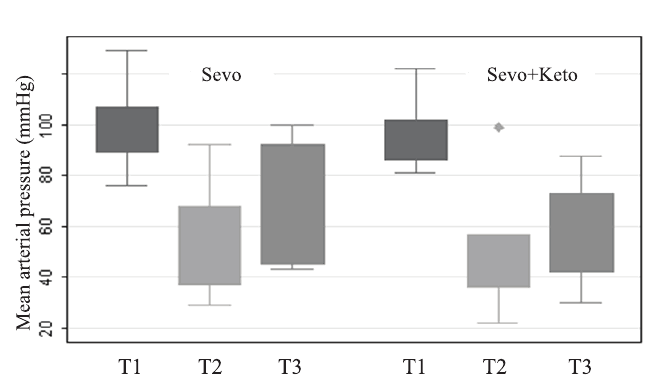
FIGURE 2 – Box-plot. Mean of the mean arterial pressure and standard deviation values (mmHg) of the rats of the sevoflurane+ketoprofen (sevo+keto) and sevoflurane (sevo) groups in the three time points studied, T1, coincident with the first hemorrhage, T2, coincident with the third hemorrhage, and T3, 30 min after T2 (p<0.001 for sevo+keto group decrease, and p<0.002 for sevo group decrease).